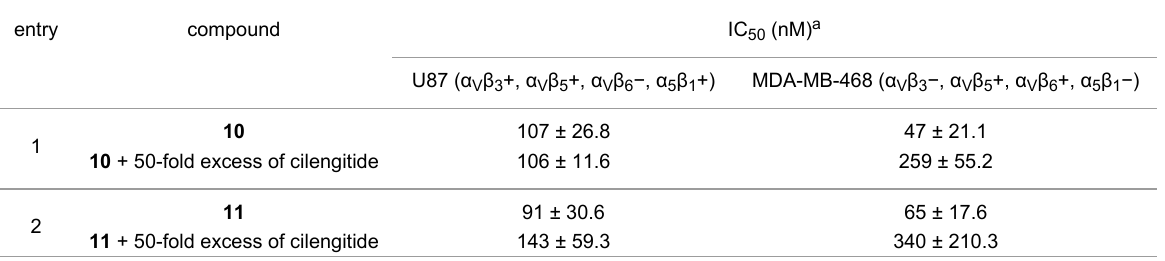
Table 4: Competition experiments of conjugates 10 and 11 in the presence of a 50-fold excess of cilengitide in U-87 and